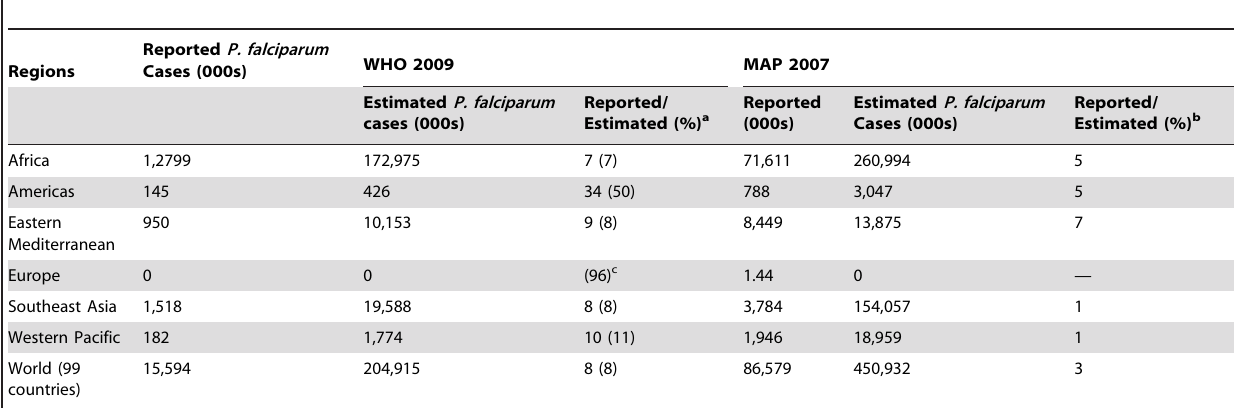
Table 4. A comparison of estimates of P. falciparum malaria cases obtained in this study for 2009 and by the MAP project for 2007.